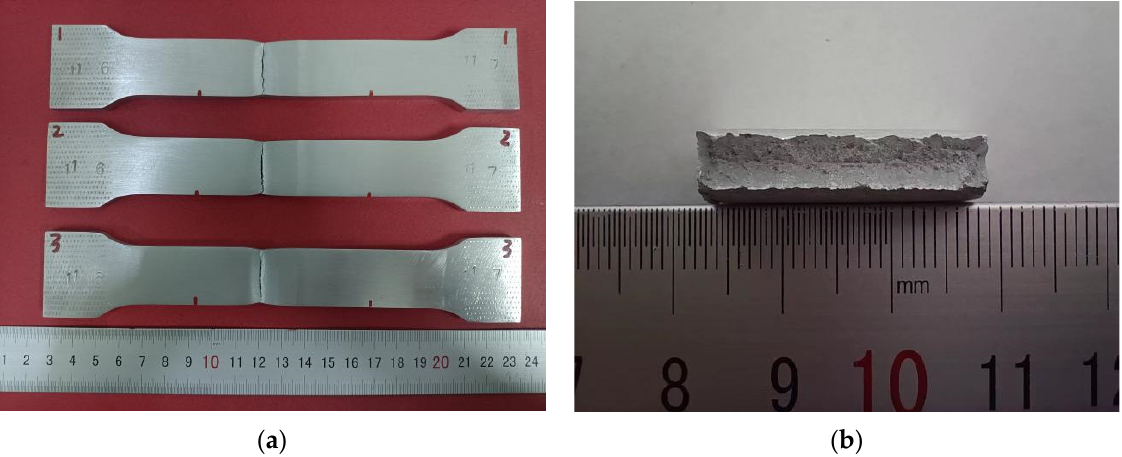
Figure 6. Macroscopic fracture morphology of tensile parts. ( a ) After breakage; ( b ) fracture section.